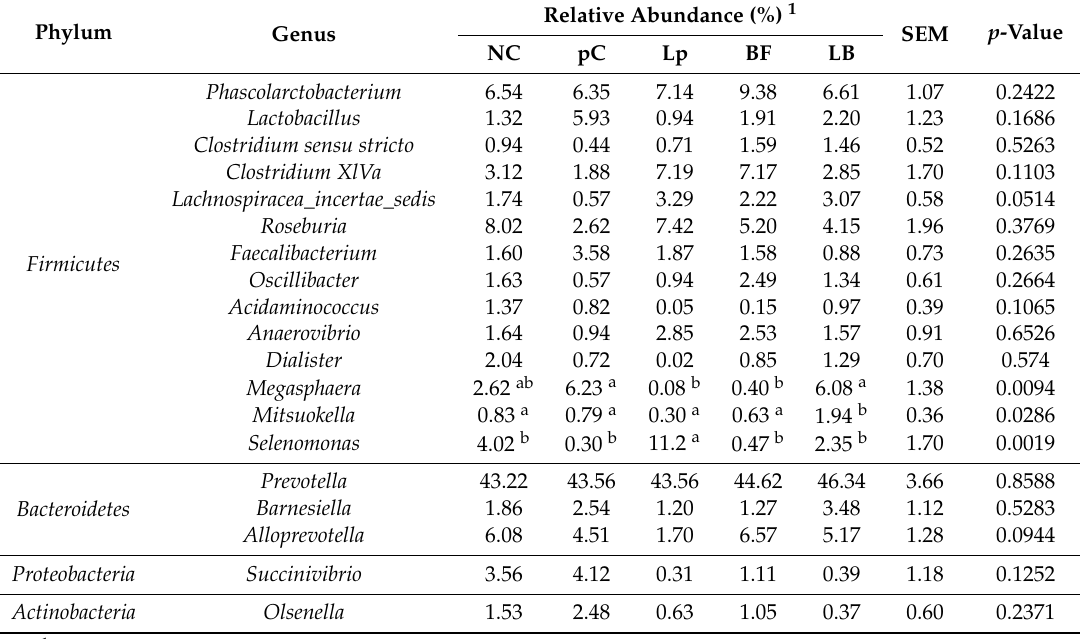
Figure 4. Effects of L. plantarum , tartary buckwheat flavones, and their combination on comparison of the dominant bacterial genera o. The color-coded bar plot shows the relative abundances of different genera across different groups. Table 6. Effects of L. plantarum , tartary buckwheat flavones, and their combination on comparison of the dominant genus of microbes.